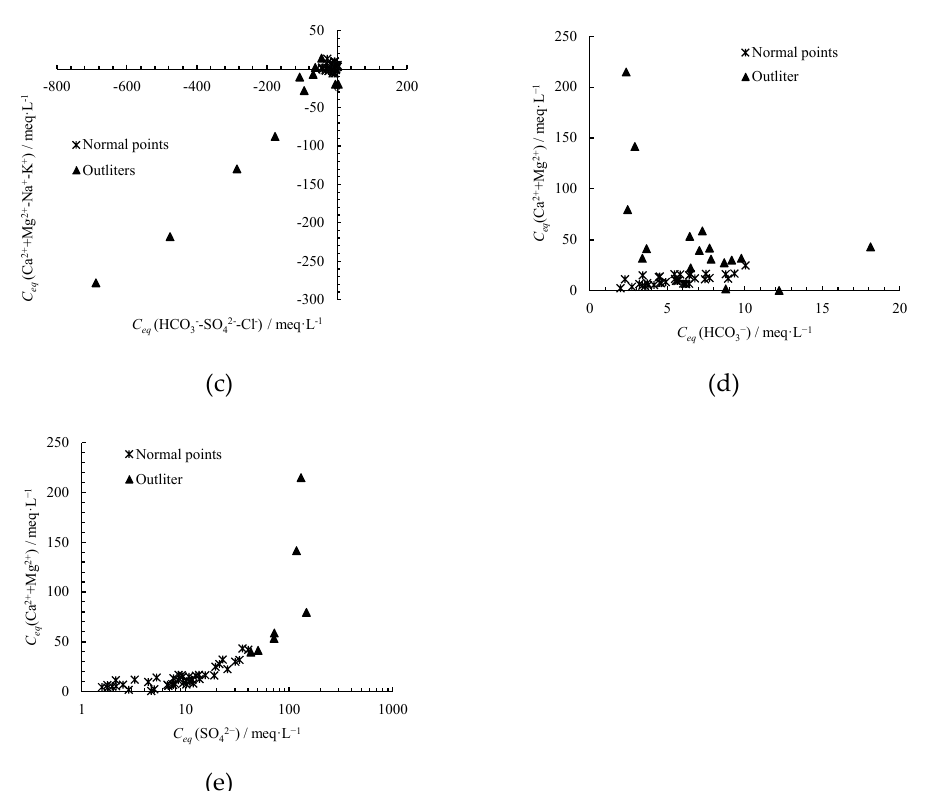
Figure 7. Identification of abnormal data by five hydrochemical diagrams. ( a ) Two-dimensional coordinate diagram of the Piper diamond area. ( b ) Na + + K + –Cl − diagram. ( c ) Ion exchange